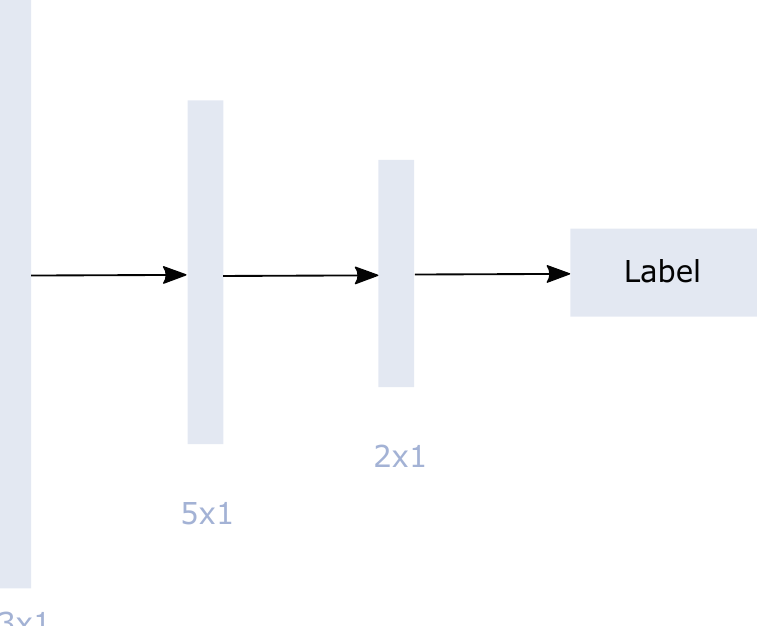
Figure 8. Flowchart of the MLP architecture for the 13 input features during the training process. The network includes two hidden layers. The implementation is a standard architecture with the selected hidden layer size using scikit-learn